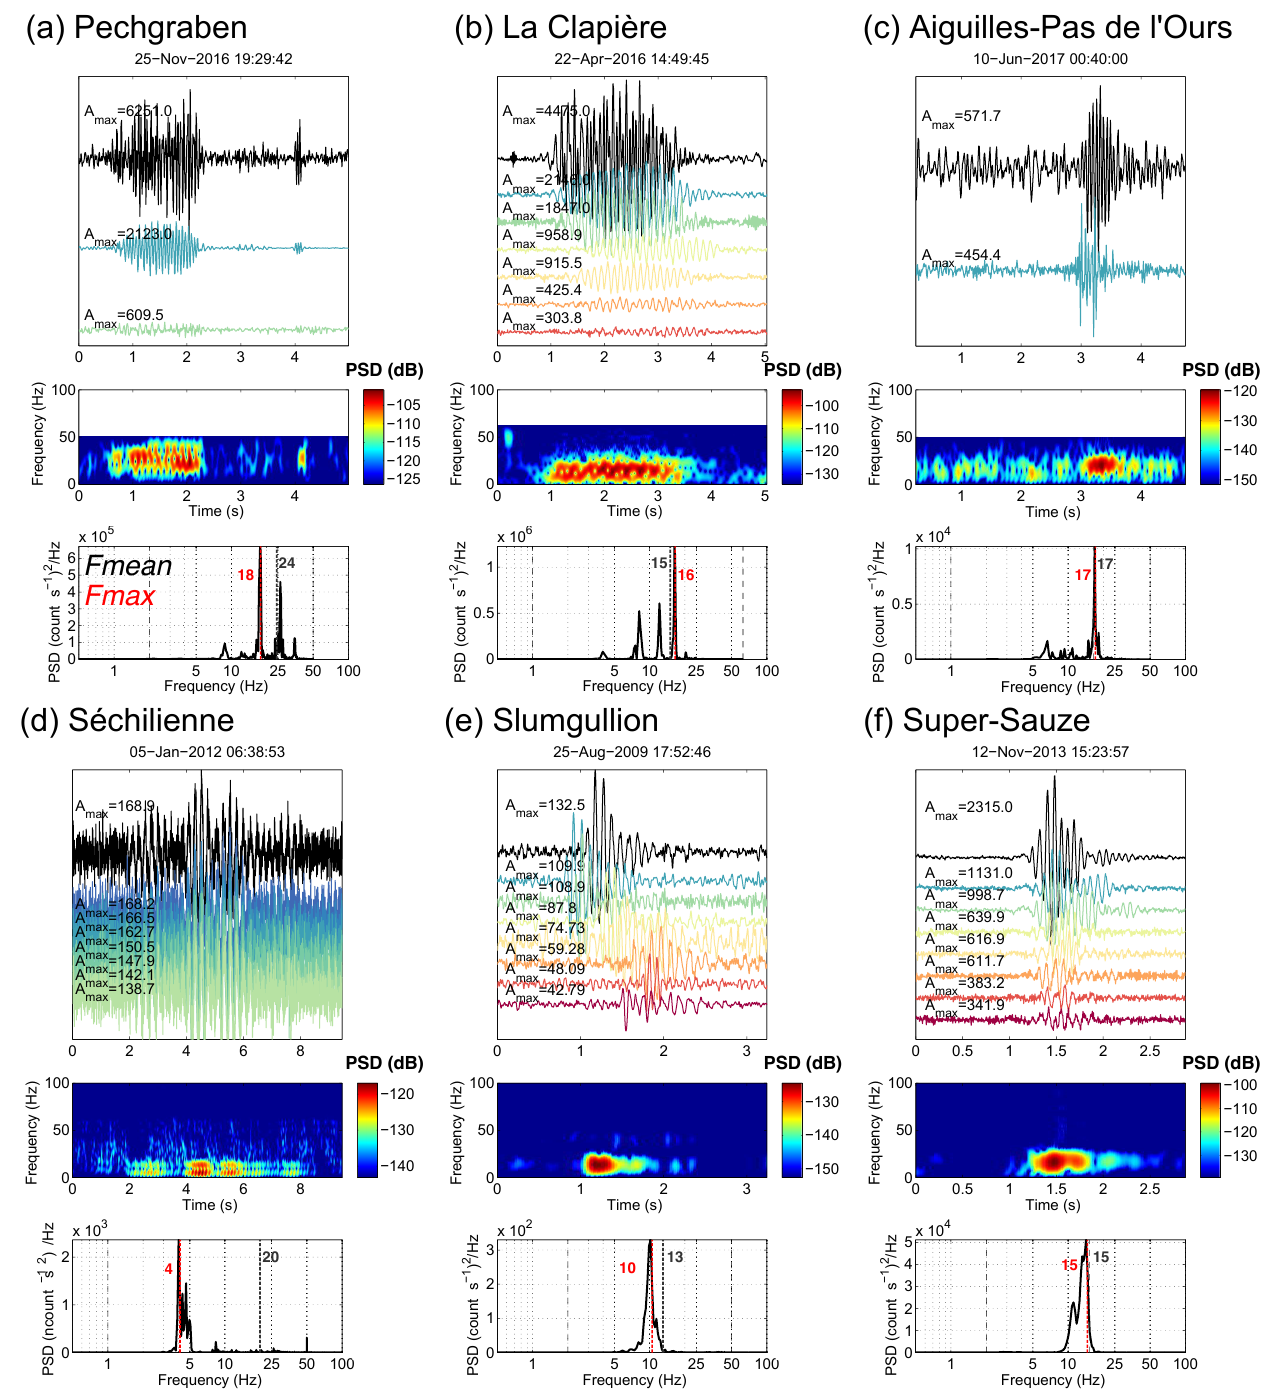
Figure 13. Examples of pure harmonic signals recorded at the (a) Pechgraben, (b) La Clapière, (c) Aiguilles-Pas de l’Ours, (d) Séchilienne, (e) Slumgullion (Gomberg et al., 2011) and (f) Super-Sauze slopes. See Fig. 2 for a description of the figure. Note that for the Slumgullion signals (e) , the amplitudes are expressed in